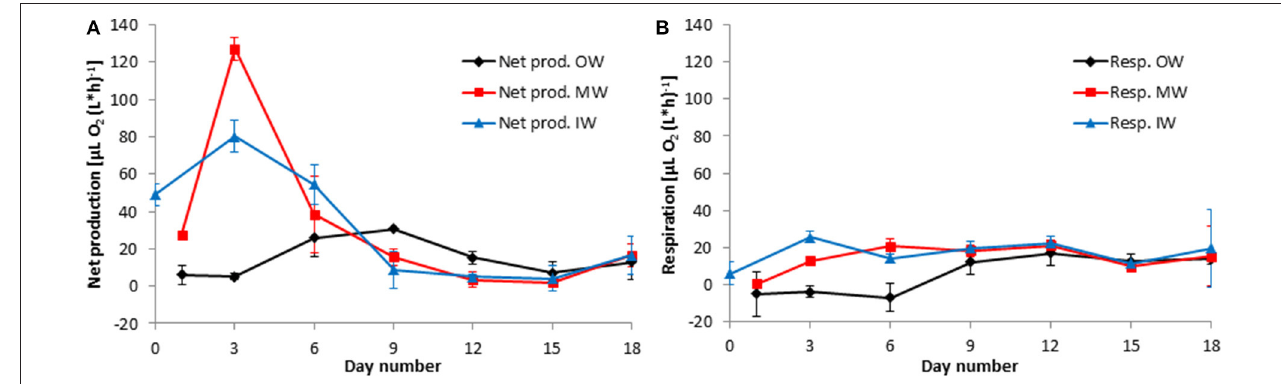
FIGURE 10 | Development of the net community production (A) and respiration rates (B) in the tanks of the experiment from winter 2013. Mean values and standard deviations of the three replicate tanks are shown.